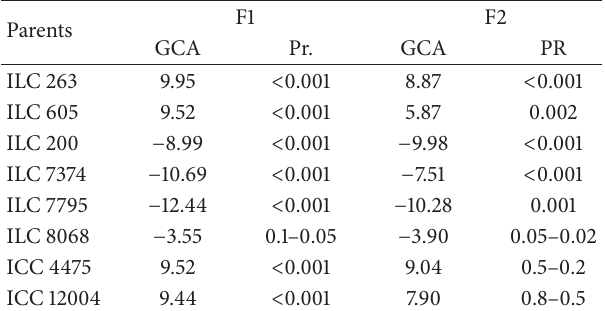
Table 11: GCA value of 8 parents at the adult